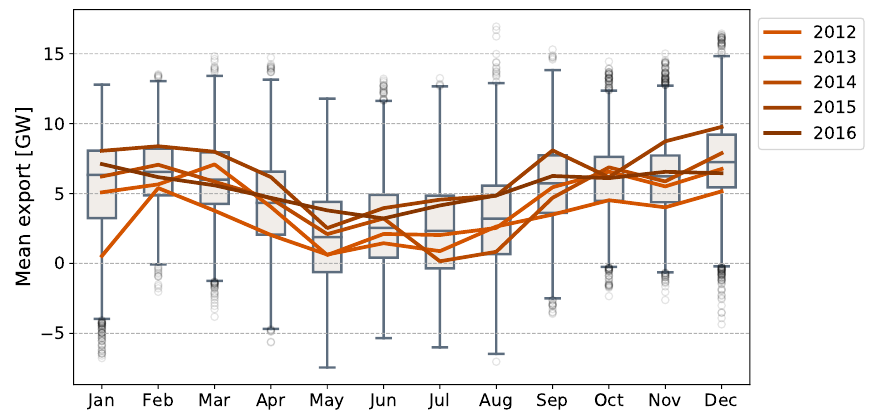
Figure 1. Distribution of commercial electricity trade (grouped monthly) balance between Germany and its neighboring countries in the CWE region displayed as box-plots, source: own illustration, data: